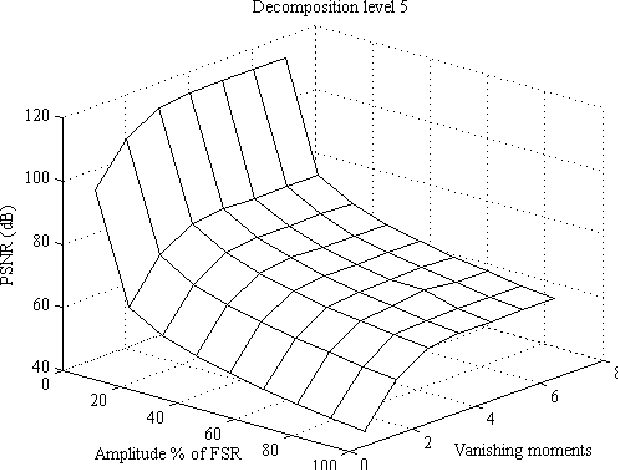
Figure 2. Result of noise reduction as a function of signal amplitude and wavelet vanishing moments.